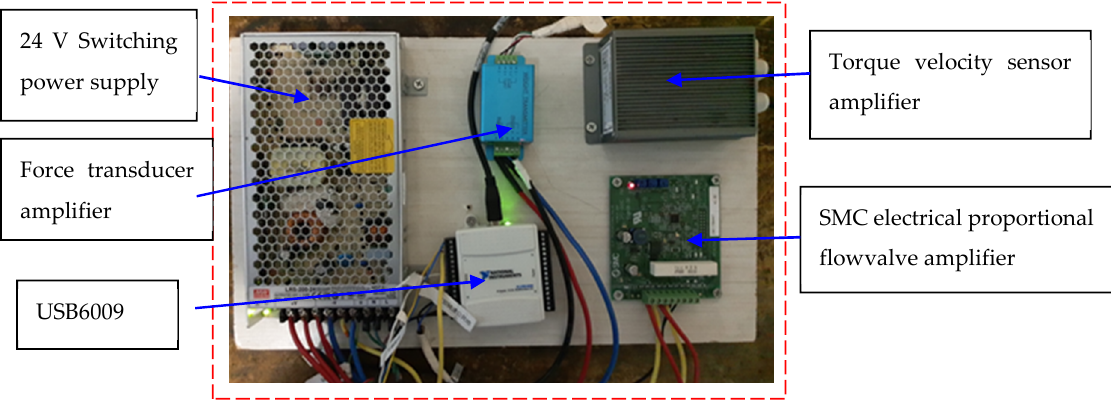
Figure 6. Hardware diagram of the unconfined compressive-strength detector test system for roadway rock.